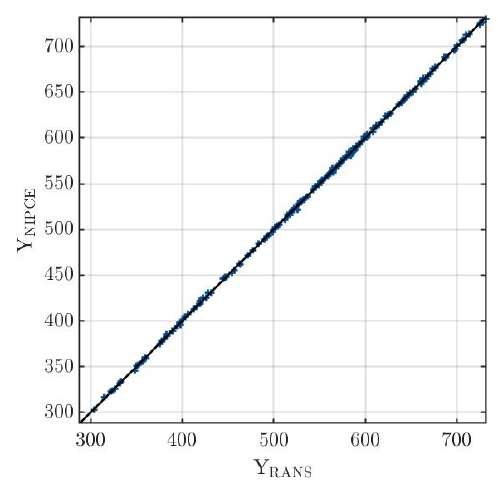
Figure 7. Non-Intrusive Polynomial Chaos Expansion (NIPCE) predicted ( M 1 ) vs. Reynolds-Averaged Navier-Stokes (RANS) calculated value for the local heat transfer coefficient at x = 11.36 cm (HAX model).